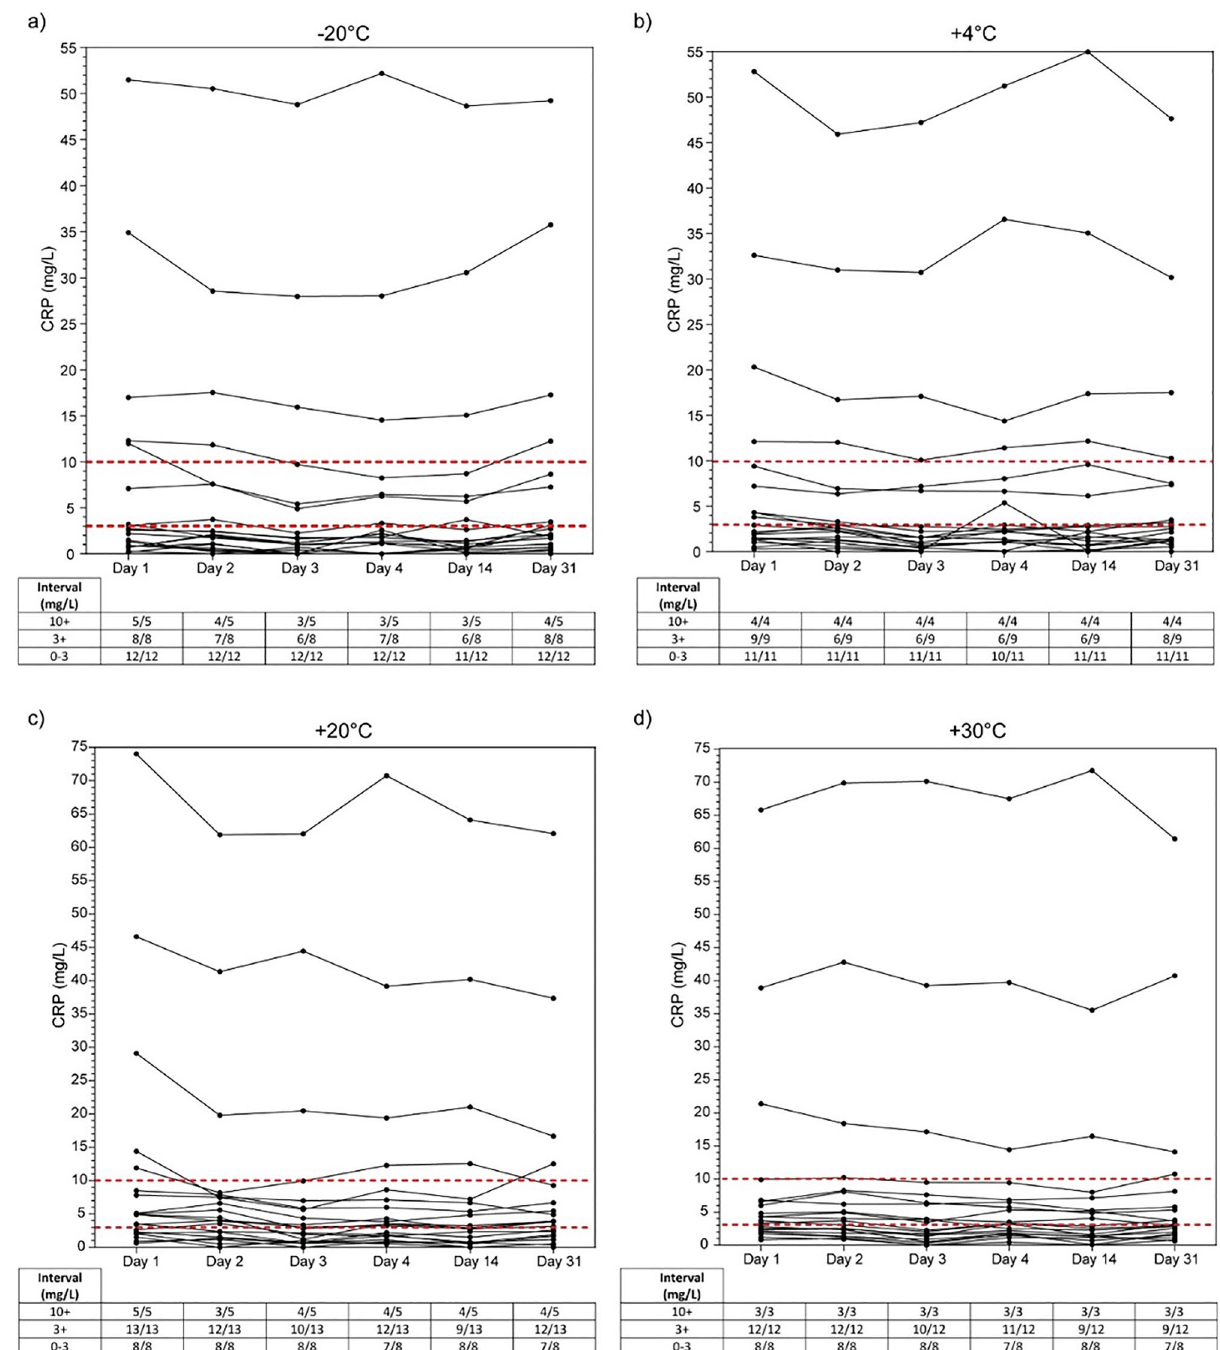
Figure 2. CRP stability. Stability of 20 patient samples after storage up to 31 days at temperatures of (A) -20 °C, (B) + 4 °C, (C) + 20 °C, and (D) + 30 °C. Clinically relevant cut-off values are represented by red lines in each panel. Under each panel, a table with a classification of patient samples per CRP interval is visible (X/X = number of samples at day X/number of samples at day